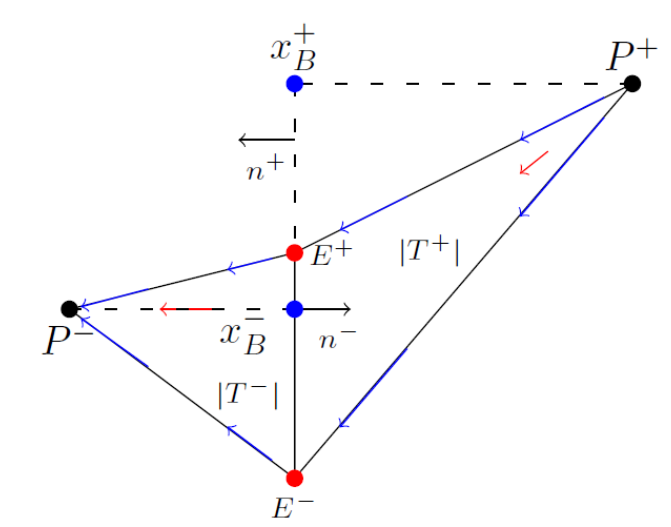
Figure 3. RT 0 -basis functions on a triangle patch ω T